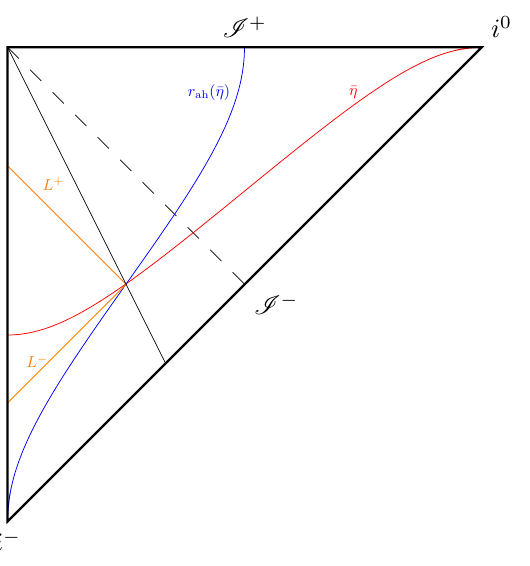
Figure 1 . Conformal Penrose diagram for a flat contracting cosmology with apparent horizon (the solid black curve) at η smaller than r = − η (drawn as the dashed line), where r is comoving distance. The lightsheet L + emanating from the apparent horizon at ¯ η focuses (ends) at the caustic point at the spatial origin at a time prior to the singularity. In this case, the second law of thermodynamics implies that the entropy S ( L + ) bounds the entropy in the region inside the apparent horizon, because L + intersects the time evolved region inside the Hubble radius at ¯ η . Then, the covariant entropy bound can be easily applied as in the expanding